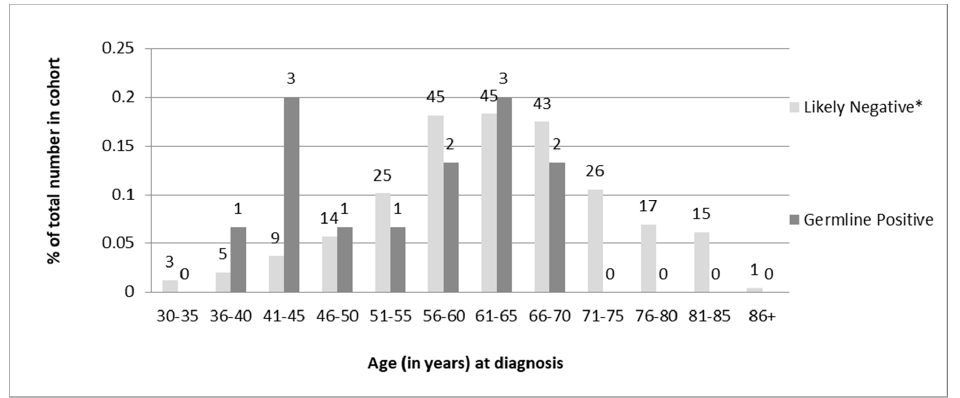
Figure 4. Comparison of the distribution of age at diagnosis of EC between likely negative and germline-positive cohorts. Actual N for each group is shown above each column. Comparison between these two groups using Fisher’s exact test revealed a statistically significant di ff erence ( p = 0.02). Note: Patients who were screen-negative based on the protocol and patients whose germline testing results were negative were considered likely negative for these analyses.